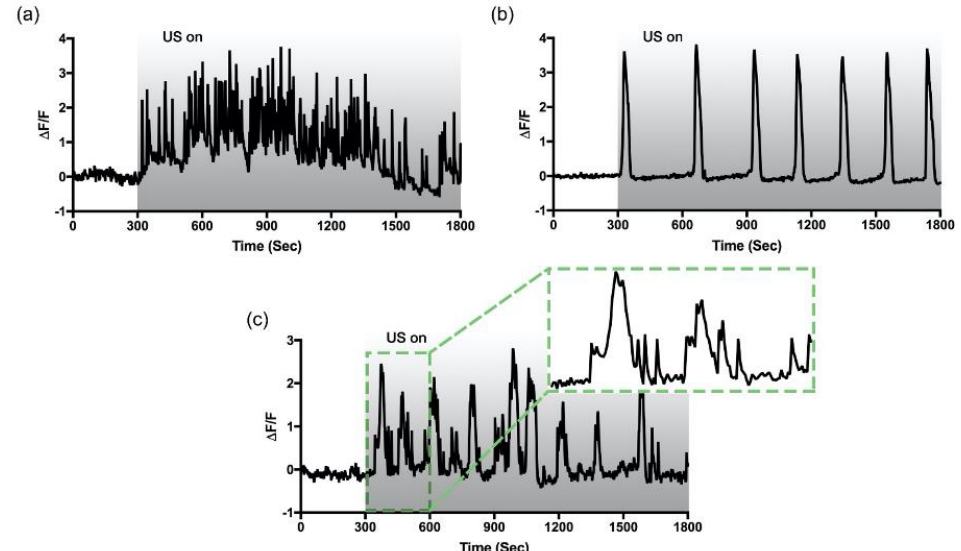
Figure 2. Different patterns of intracellular Ca 2+ oscillations evoked by ultrasound. Clusters of HIT-T15 cells were exposed to low-intensity pulsed ultrasound for 25 min starting at t = 300 s. The gray bar indicates the duration of ultrasound exposure. Fast-irregular ( a ), and slow-periodic ( b ) oscillation patterns were dominantly observed from the cells adapted to 11.1 mM (stimulating) and 5.5 mM (non-stimulating) of glucose, respectively. Seldomly, mixed ( c ) oscillation patterns were also monitored in the both conditions.